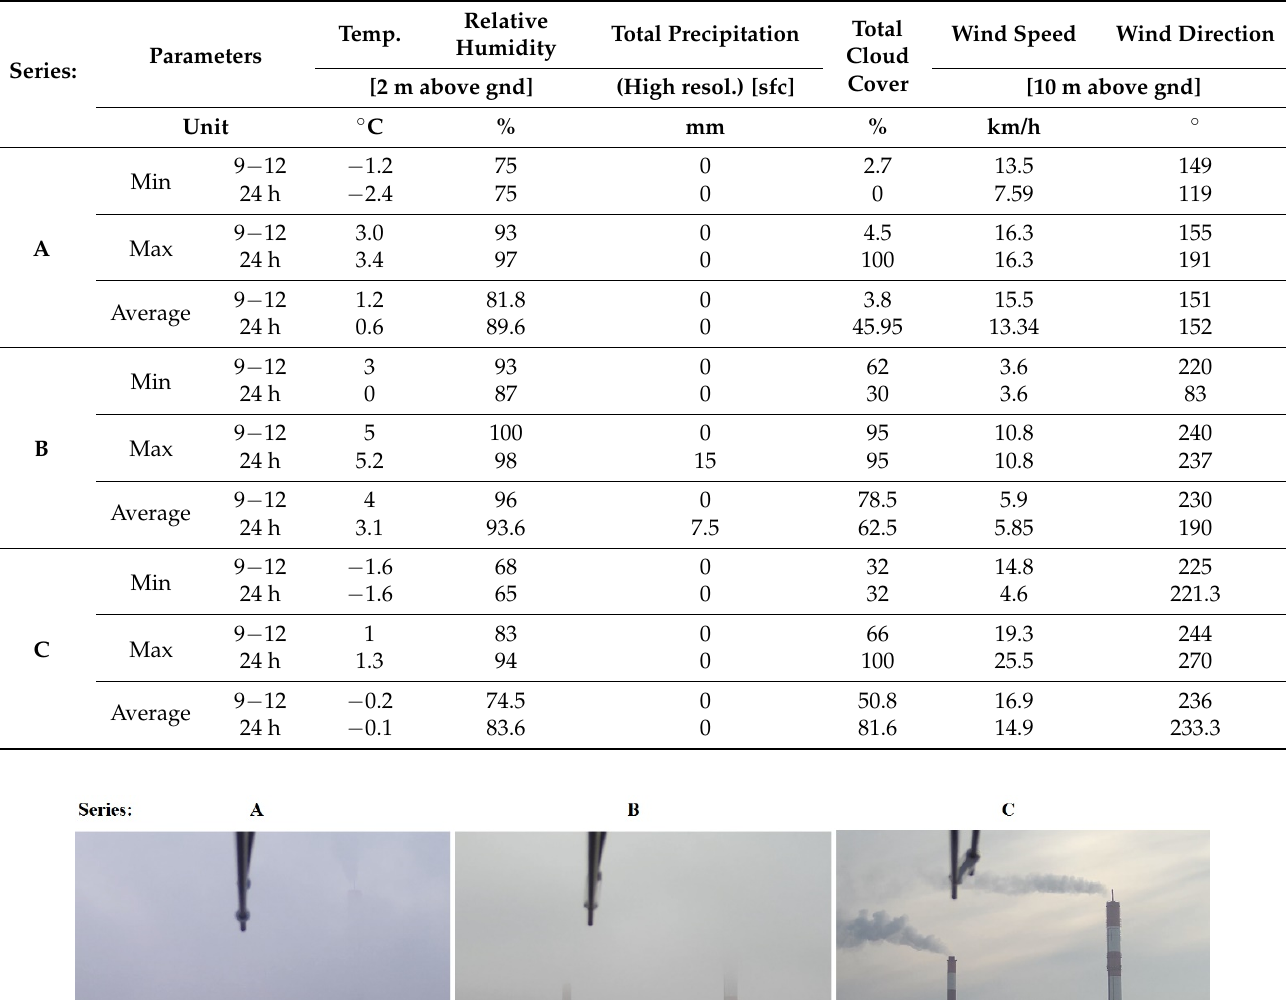
Table 1. Statement of meteorological parameters (data source: www.meteoblue.com).